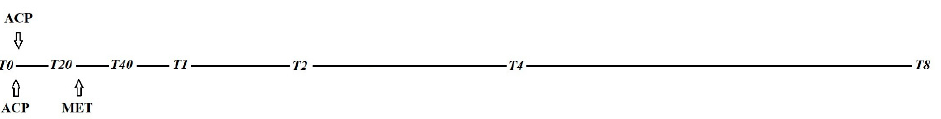
Figure 1. Timeline of events illustrating STT 1 readings, intramuscular administration of acepromazine (ACP, 0.015 mg/kg) alone or acepromazine + methadone after 20 min (ACP+MET, 0.01 mg/kg and 0.2 mg/kg, respectively).